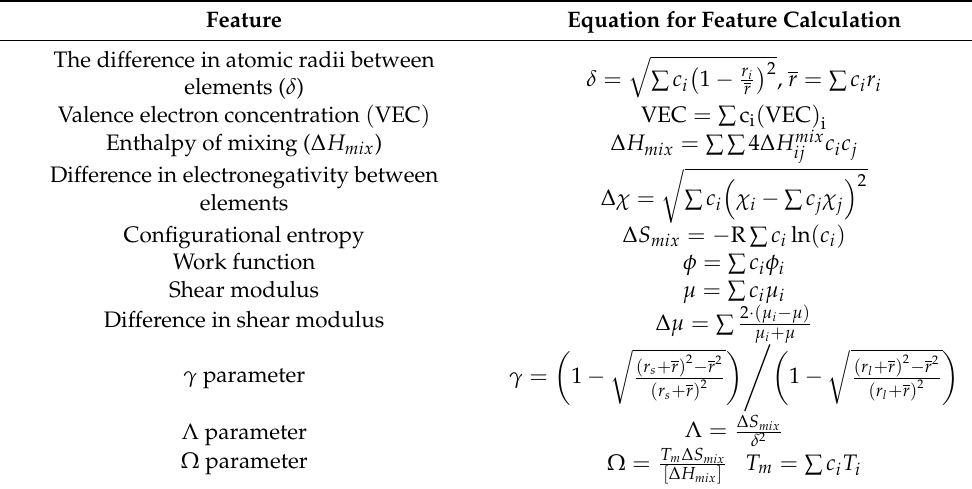
Table 1. List of input features for the surrogate prediction